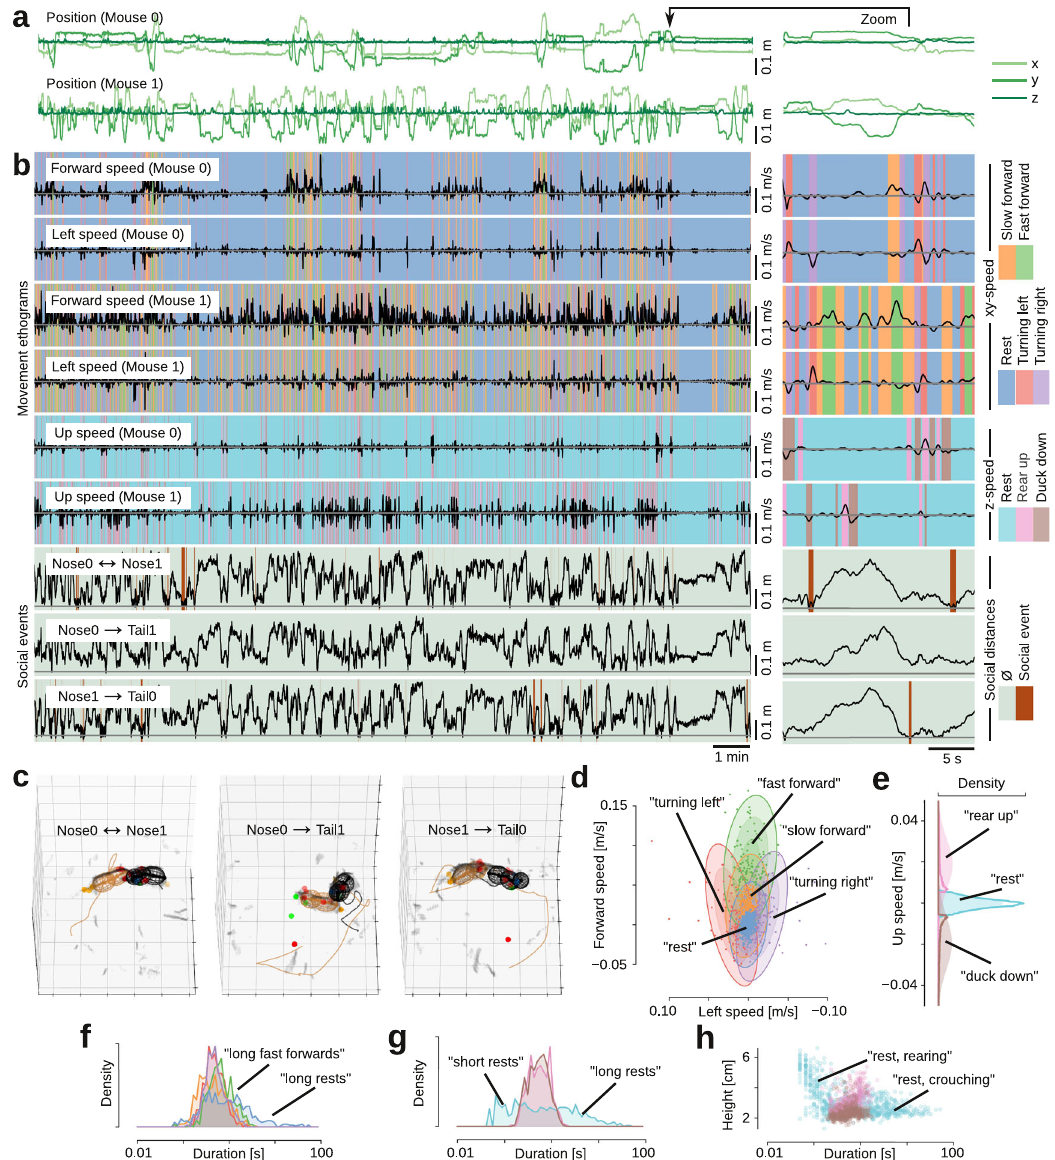
Fig. 5 Automatic classi fi cation of movement patterns and behavioral states during social interactions. a Tracked position of both mice, across an example 21 min recording. b Extracted behavioral features: three speed components (forward, left, and up in the mice ’ s egocentric reference frames), and three ‘ social distances ’ (nose-to-nose distance and two nose-to-tail distances). Colors indicate ethograms of automatically detected behavioral states. c Examples of identi fi ed social events: nose-to-nose-touch, and anogenital nose-contacts. d Mean and covariance (3 standard deviations indicated by ellipsoids) for each latent state for the forward/leftward running (dots indicate a subsample of tracked speeds, colored by their most likely latent state) e Mean and variance of latent states in the z -plane (shaded color) as well as distribution of tracked data assigned to those latent states (histograms) f Distribution of the duration of the fi ve behavioral states in the xy -plane. Periods of rest (blue) are the longest ( p < 0.05, two-sided Mann – Whitney U- tests) and bouts of fast forward movement (green) are longer other movement bouts ( p < 0.001, two-sided Mann – Whitney U-tests). g Distribution of duration of the three behavioral states in the z -plane. Periods of rest (light blue) are either very short or very long. h Plot of body elevation against behavior duration. Short periods of rest happen when the z -coordinate is high (the mouse rears up, waits for a brief moment before ducking back down), whereas long periods of rest happen when the z -coordinate is low (when the mouse is resting or moving around the arena, ρ = − 0.47, p < 0.001, two-sided Spearman ’ s rank correlation coef fi cient test). Source data and analysis scripts that generate the fi gures are available in the associated code/data fi les (see “ Methods ” naturalistic behavior. During free behavior, touch, movement, To deal with these challenges, we drew inspiration from the and postural changes happen simultaneously, as continuous and and developed a fully-automatic python pipeline that can overlapping variables. Furthermore, in line with “ vicarious ” automatically discover ‘ social ’ receptive fi elds. Our tracking somatosensory responses reported in human somatosensory method is able to recover the 3D posture and head direction of cortex 60 and barrel cortex responses observed just before touch 61 , barrel cortex neurons may be related to the behavior of the both animals: The head direction of the implanted animal was partner animal, in a kind of “ mirror neuron ” -like response. given by the skeleton of the body model (the implant is fi xed to